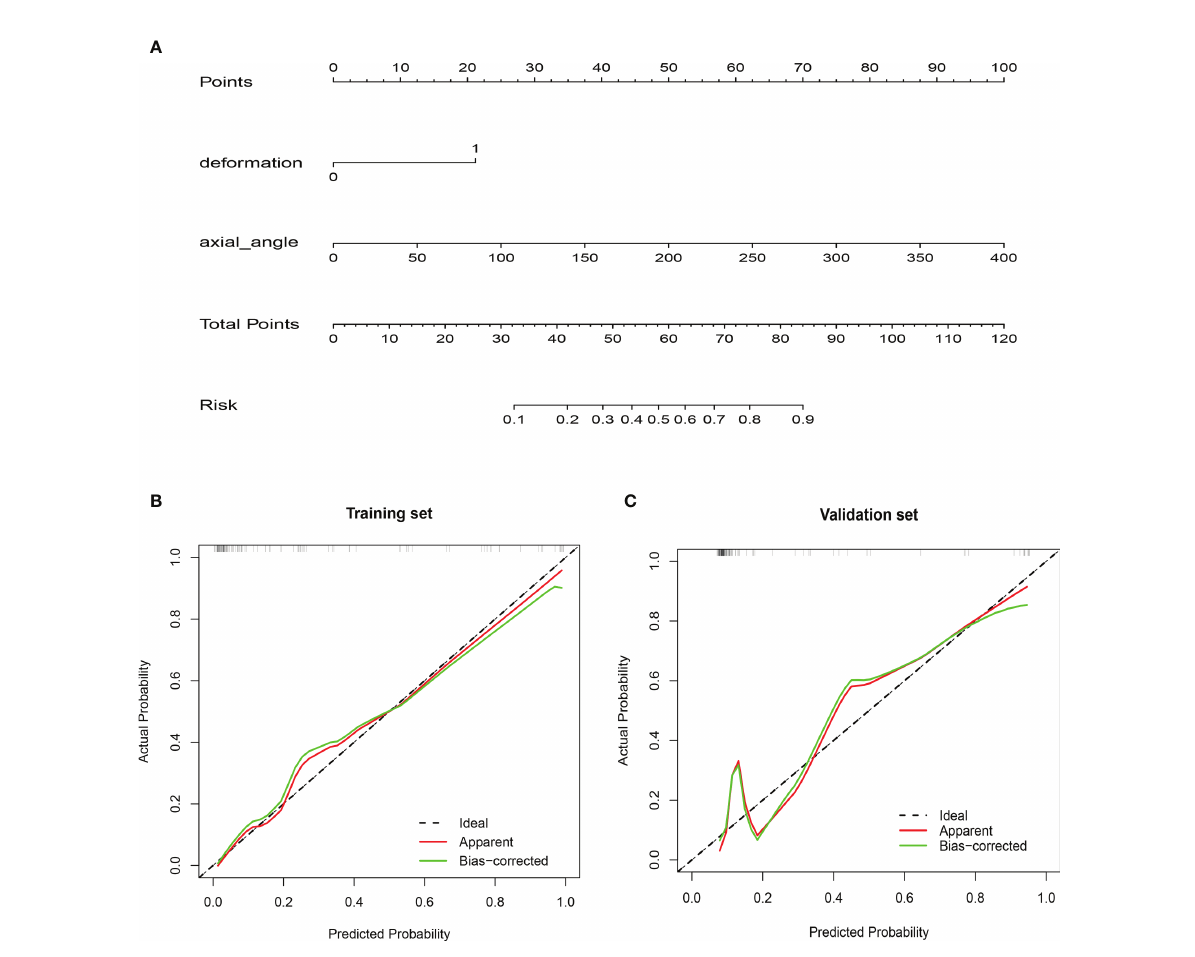
FIGURE 4 Nomogram and calibration curves. (A) A nomogram was constructed in the training cohort, with vascular deformation and the degree of encasement of the carotid artery incorporated. Each risk variable was listed separately on the nomogram with a corresponding number of points assigned to a given variable magnitude. Then, the cumulative point score for all variables matched the “ diagnostic possibility, ” which was the carotid artery invasion probability of the patient. Calibration curves of the nomogram in the (B) training and (C) validation cohorts. The calibration curve of the prediction model demonstrated that the estimated risks were in agreement with the observed risks of carotid artery invasion in both the training and validation